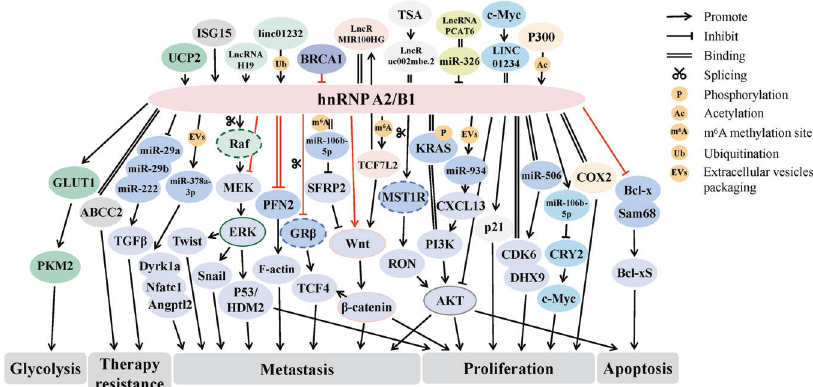
Fig. 4 Representative molecular mechanisms of hnRNPA2/B1 in cancer. HnRNPA2/B1 affected the proliferation, metastasis, apoptosis, glycolysis and therapy resistance of cancer cells, mainly by regulating PI3K/Akt, Wnt/ β -catenin, MAPK/ERK and other signaling pathways. HnRNPA2/B1 participated in cancer process not only as a cancer driver gene but also as a “ cooperator ” of other drivers such as ISG15, UCP2, MIR100HG, LINC01234, miR-934 and miR-378a-3p. Moreover, the stability and expression of hnRNPA2/B1 could be adjusted by Linc01232, P300, lncRNA H19 and so on. Among them, the function and mechanisms of hnRNPA2/B1 in BC remained controversial (highlighted with